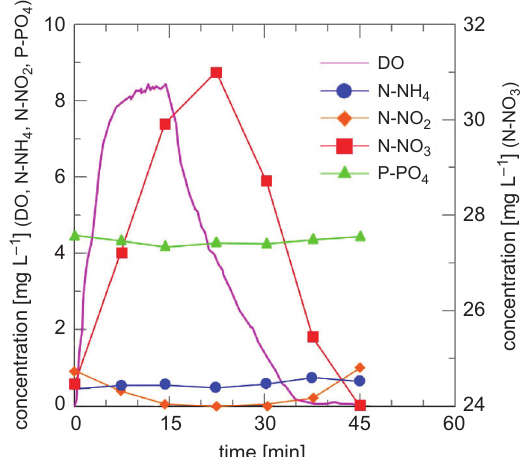
Fig. 2 – Oxygen, ammonium, nitrite, nitrate, and phosphorus concentration profiles in the IACMB. Operating cycle (15–30), t = 15 min, t = 30 min. aer mix